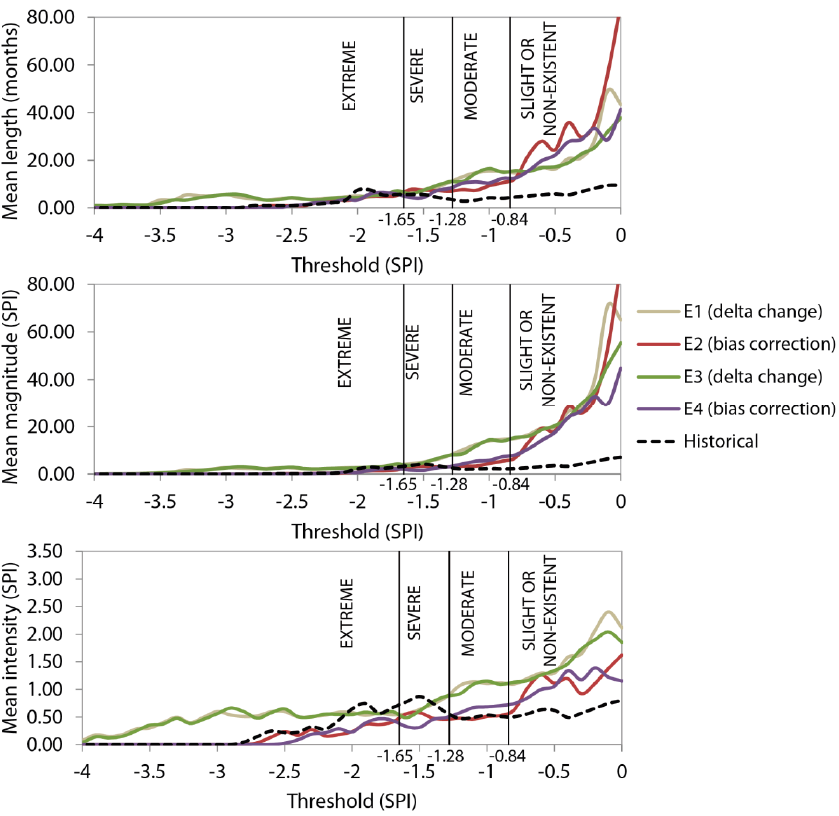
Figure 13. Drought statistics of future precipitation series obtained by the four ensemble options (E1, E2, E3, and E4)—lumped approaches.